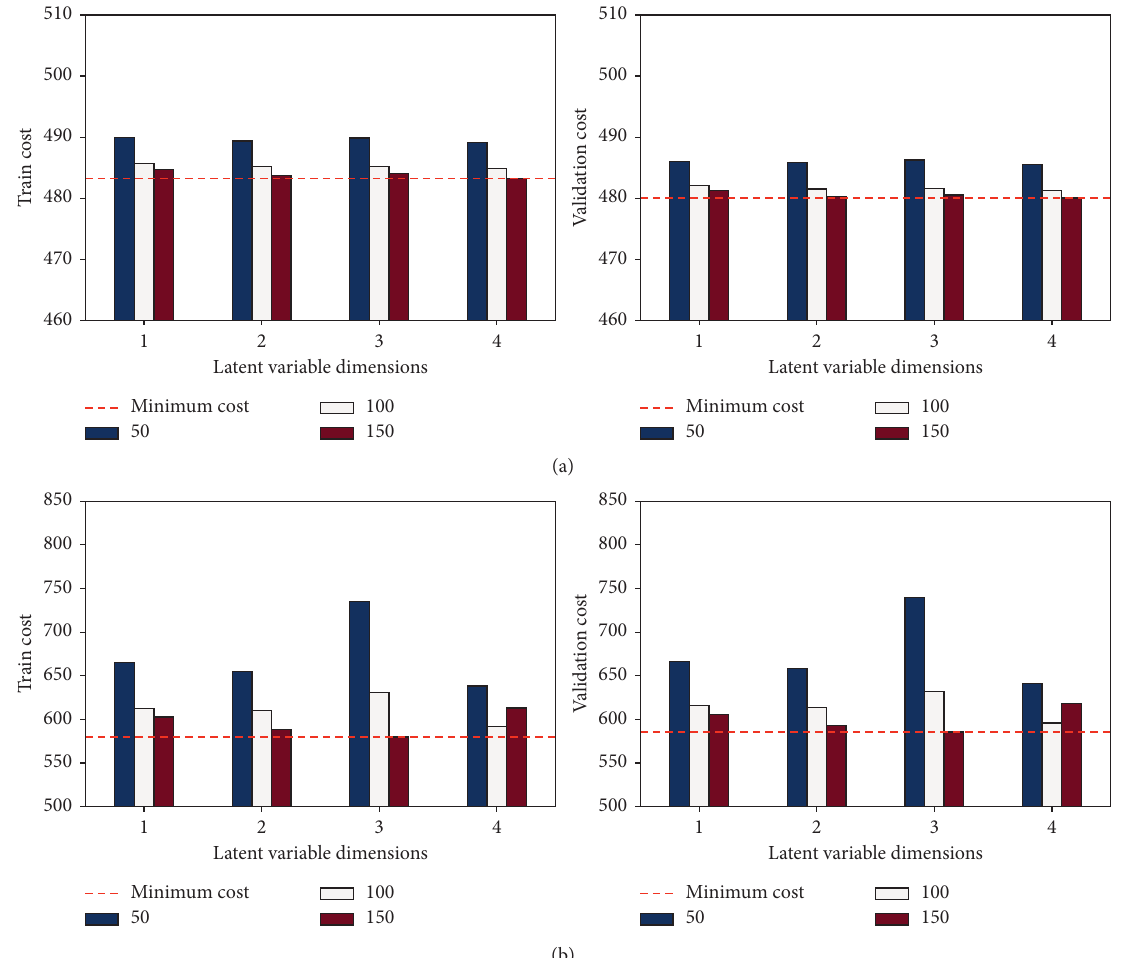
Figure 2: Sensibility analysis of the cost function by the number of training epochs. (a) FD001. (b)